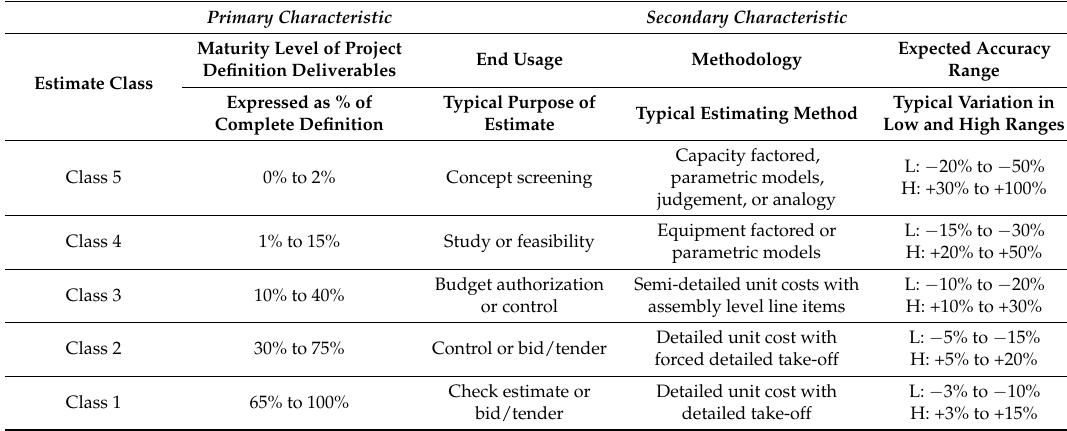
Table 1. Cost estimation classes (Reprinted with the permission of Christensen, P; Dysert, L.R, AACE International, Morgantown, WV, USA, 2016 [25]). Copyright © 2016 by AACE International; all rights